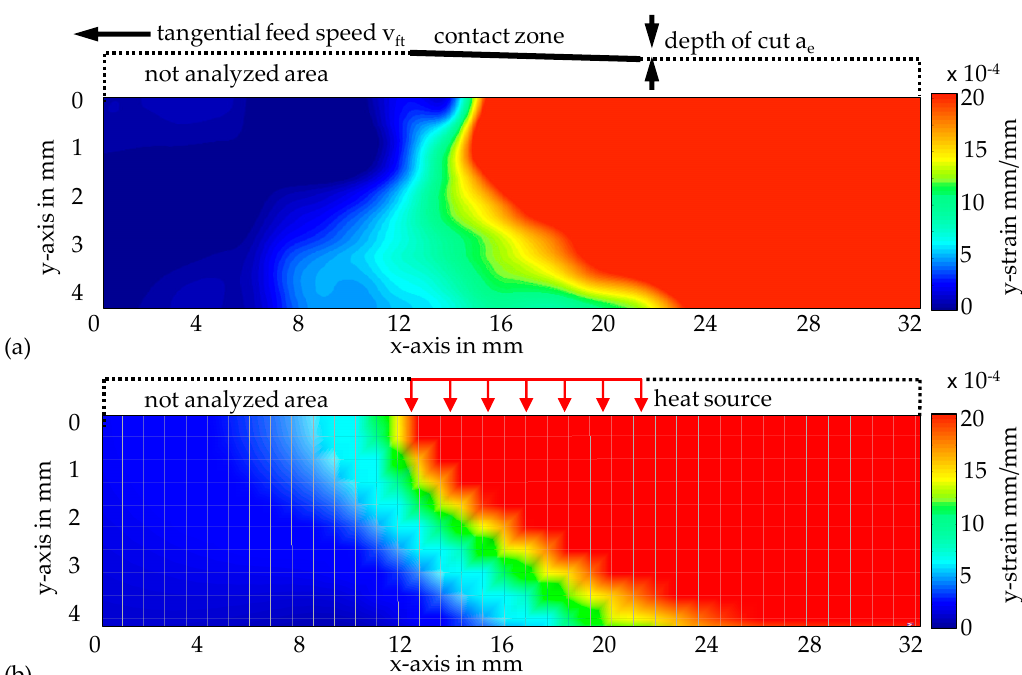
Figure 9. Total strain during the process in normal direction: ( a ) calculated from the speckle photography measurements; ( b ) simulated.